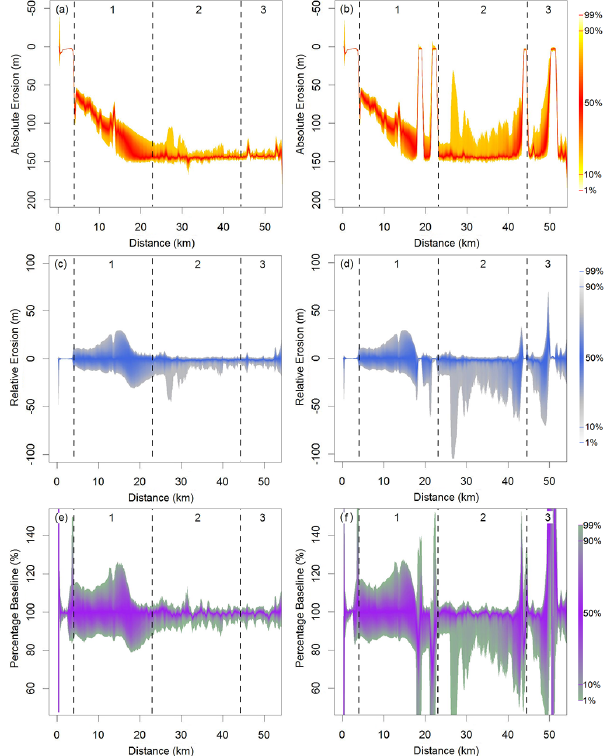
Figure 3. Simulated erosion for the Holderness coastline. Simu- lated absolute change in coastline position (2010–2100) predicted using an ensemble of future wave climates for undefended (a) and defended (b) coasts. Relative change in coastline position (relative to baseline simulation) for each member of the ensemble, for the un- defended (c) and defended (d) simulations respectively. Percentage change in erosion relative to the baseline simulation for the unde- fended (e) and defended (f) simulations, respectively. The range of colours in each plot represents the ensemble percentiles as given on the right of the figures. The regions 1, 2 and 3 refer to the three coastal sections facilitating along-coast comparison, as defined in the